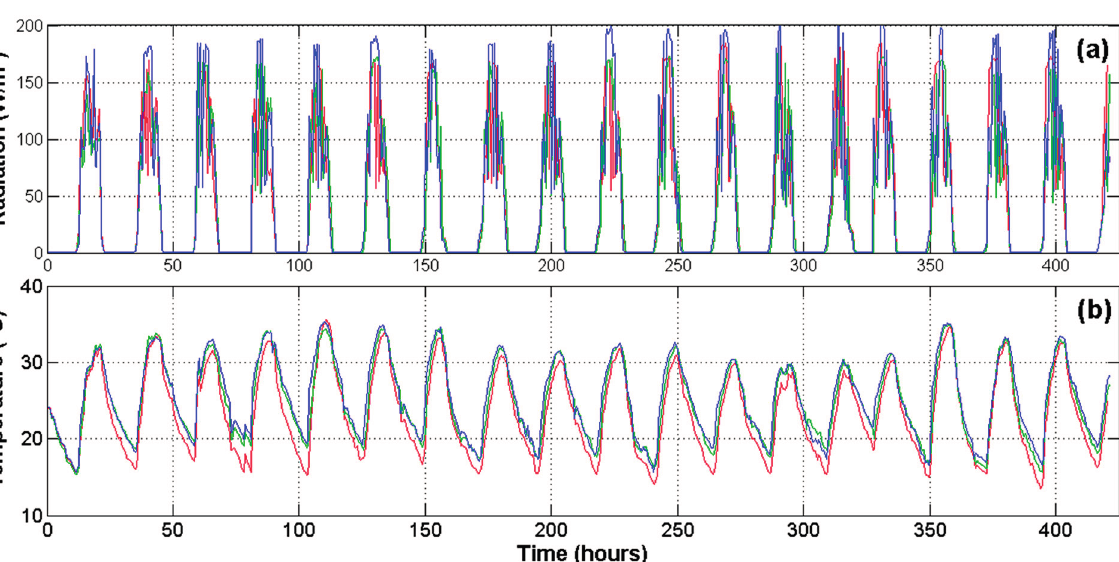
Figure 7. WSN environmental readings inside the greenhouse at locations of Nodes 1, 2 and 3. ( a ) Solar radiation; ( b ) air temperature; ( c ) vapor pressure deficit; and ( d ) relative